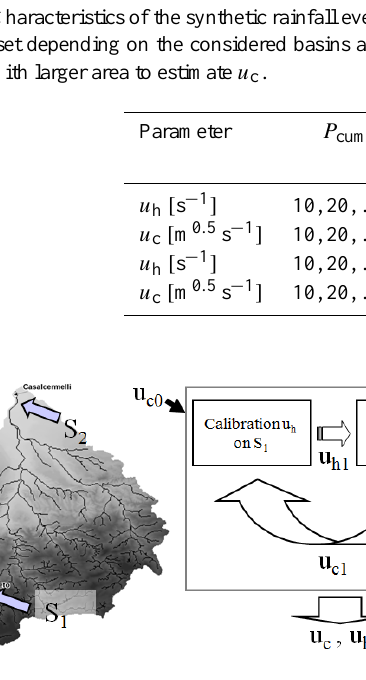
Figure 3. Scheme of calibration of the surface parameters in R. S. approach based on the reproduction of the basin lag time at two different closure sections using synthetic rainfall events. A first- guess u c is used to calibrate u h on section S 1 , this latter is used to calibrate u c on S 2 , then the procedure is iterated for N